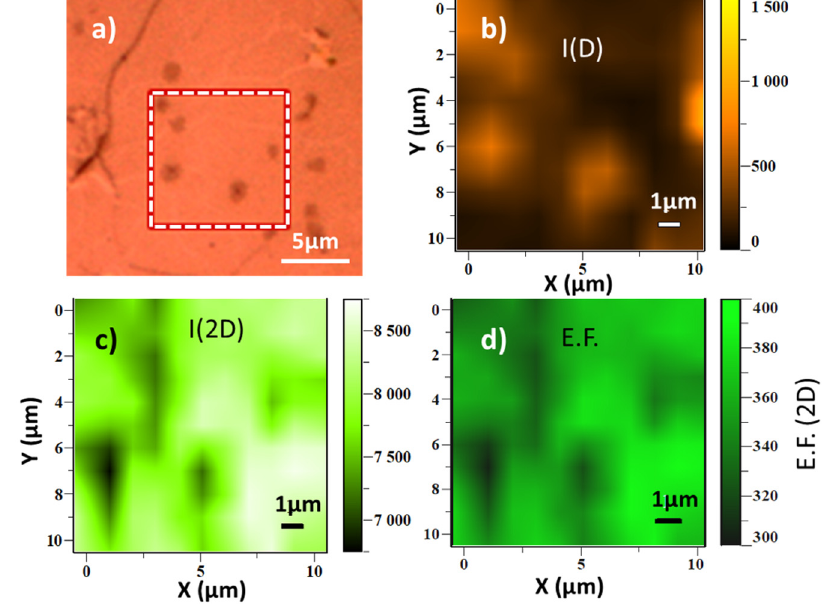
Figure 5. ( a ) Optical image of graphene on a 100 nm membrane, the 10 µ m × 10 µ m white dashed square is the tested area in the Raman images of ( b ) D peak intensity, ( c ) 2D peak intensity and ( d ) enhancement factor E.F. = I 2D (membrane) / I 2D (fused silica).